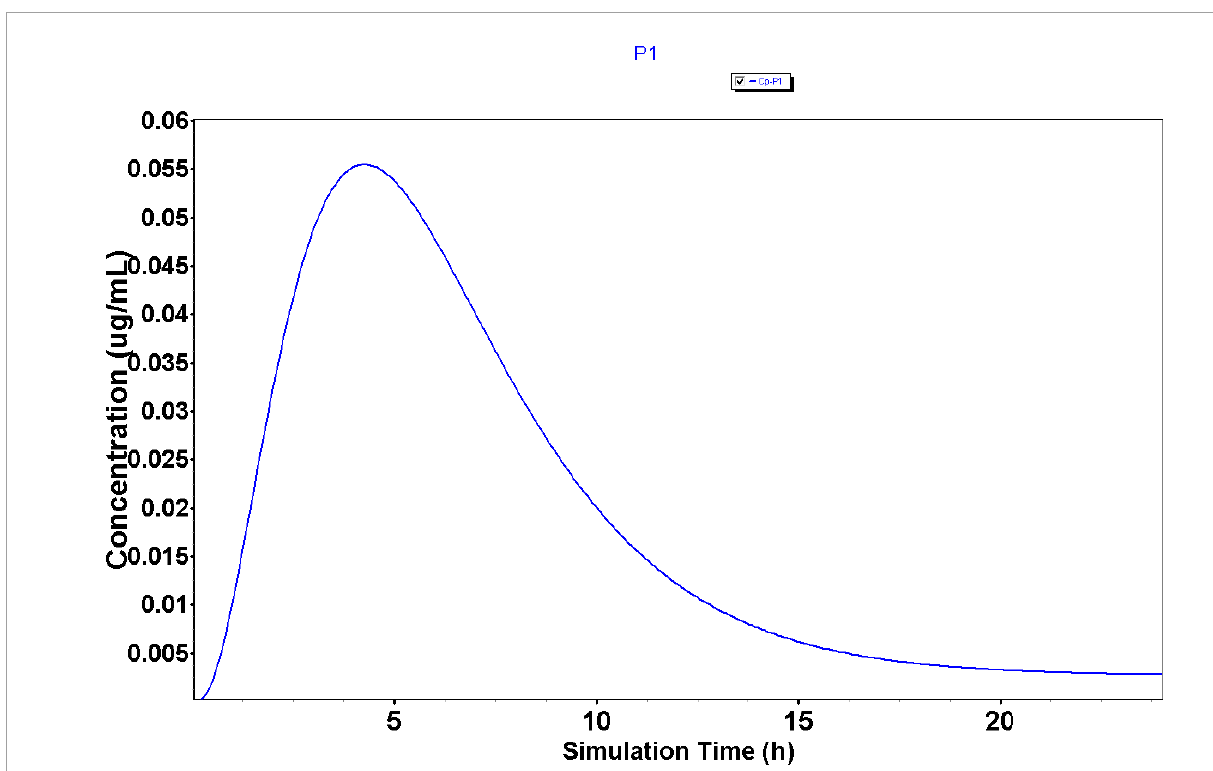
Figure 4. Plasma concentration of P1 generated using the GastroPlus ® software.